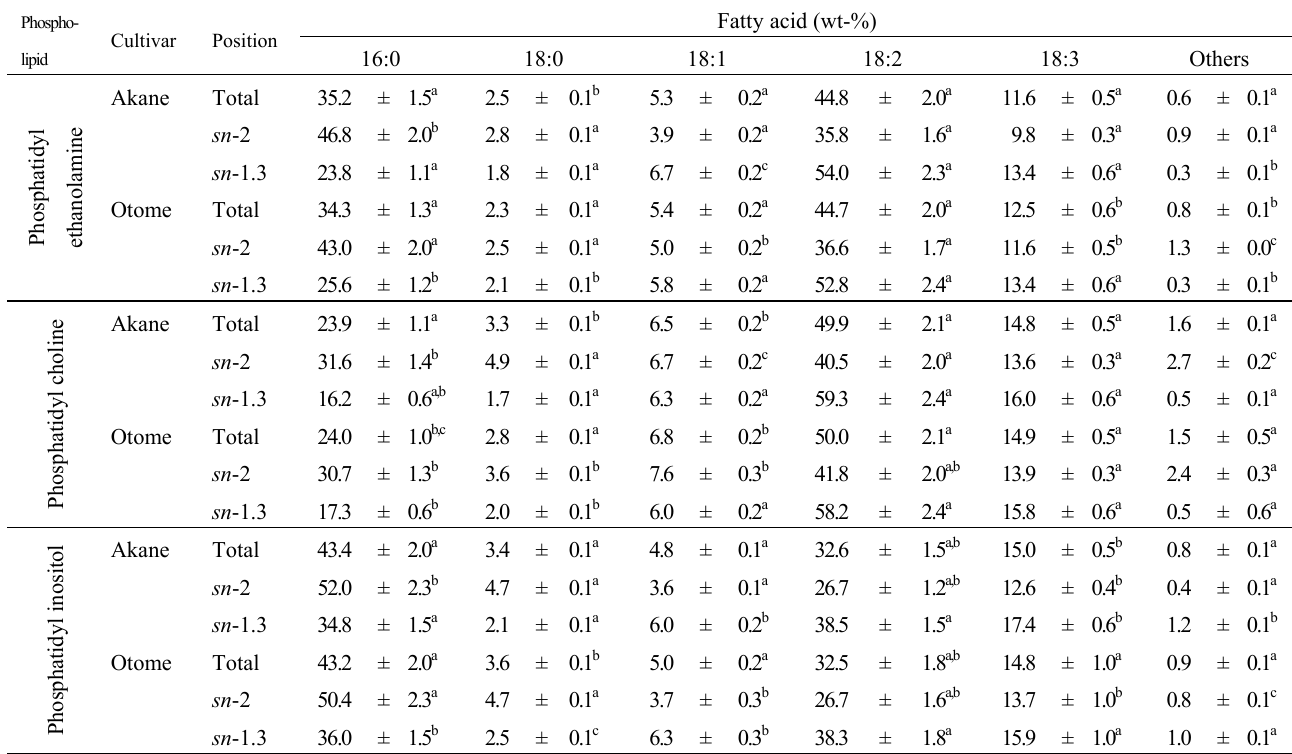
Table 3. Composition and positional distribution of fatty acids of major phospholipids obtained from adzuki beans †